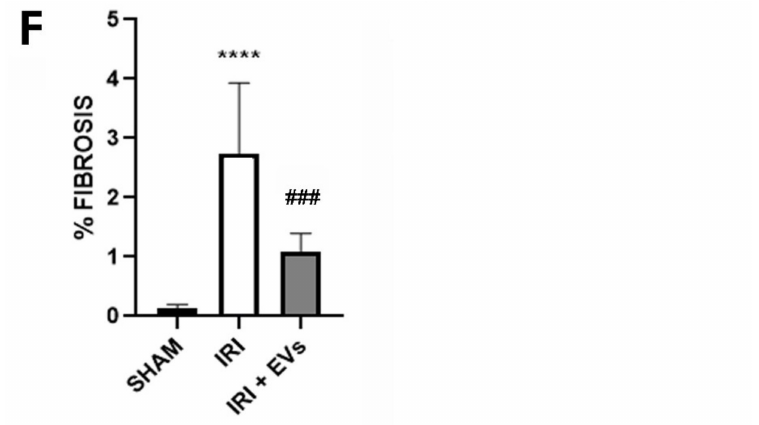
Figure 2. Effects of HLSC-EVs on kidney function and morphology in IRI-mice that were sacrificed two months after the surgery. ( A ) Schematic representation of the experimental design to test HLSC-EVs in an IRI murine model of CKD development, showing the time of surgery, of HLSC-EV administration, and of sacrifice. ( B , C ) Blood urea nitrogen (BUN) ( B ) and creatinine ( C ) plasma levels that are expressed as mg/dL were measured as biomarkers of renal function of SHAM control mice (SHAM, n = 5) and of IRI-mice i.v.-injected with HLSC-EVs (IRI + EVs, n = 8) or with the vehicle alone (IRI, n = 8) and sacrificed two months after the surgery. The data that are shown for BUN and creatinine analysis are represented as the mean ± SD. Statistical analysis was performed using analysis of variance (ANOVA) with Tukey’s multicomparison test: * p < 0.05 IRI + EVs vs SHAM and ** p < 0.002 IRI-mice vs SHAM for BUN analysis; ** p < 0.01 IRI vs SHAM and # p < 0.05 IRI + EVs vs IRI-mice for creatinine analysis. ( D , E ) Representative light microscopy micrographs of renal histology of IRI-mice IV-injected with the vehicle alone ( D ) or with HLSC-EVs ( E ) two months after the surgery (original magnification: 400 × ). ( F ) Histological quantification of fibrosis in SHAM, IRI + EVs, and IRI-mice that were sacrificed two months after the surgery, expressed as percentage of fibrosis within the total area and evaluated by multiphase image analysis of 10 fields per section (original magnification: 400 × ). The data are represented as the mean ± SD. Statistical analysis was performed using ANOVA with Tukey’s multicomparison test: **** p < 0.0001 IRI vs SHAM mice and ### p < 0.001 IRI + EVs mice vs